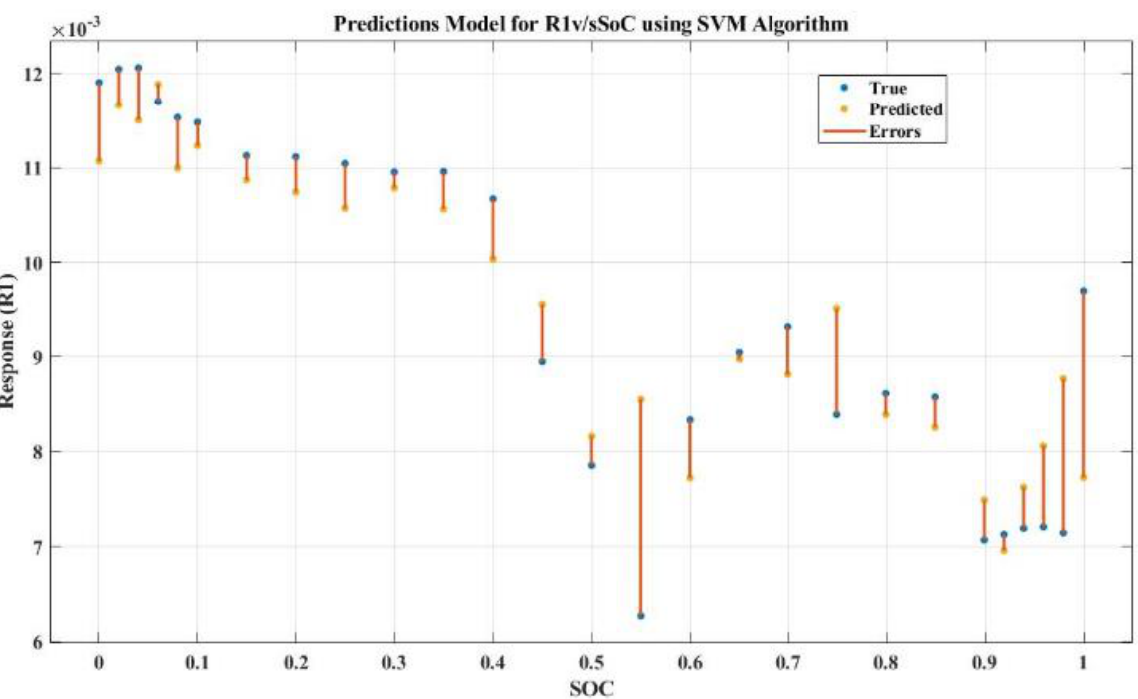
Figure 22. Prediction model for parameter estimation: R 1 vs. SOC.